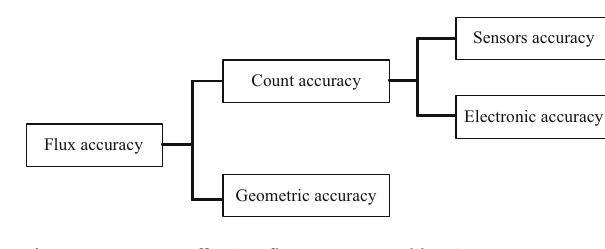
Figure 10: Factors a ff ecting fl ux accuracy